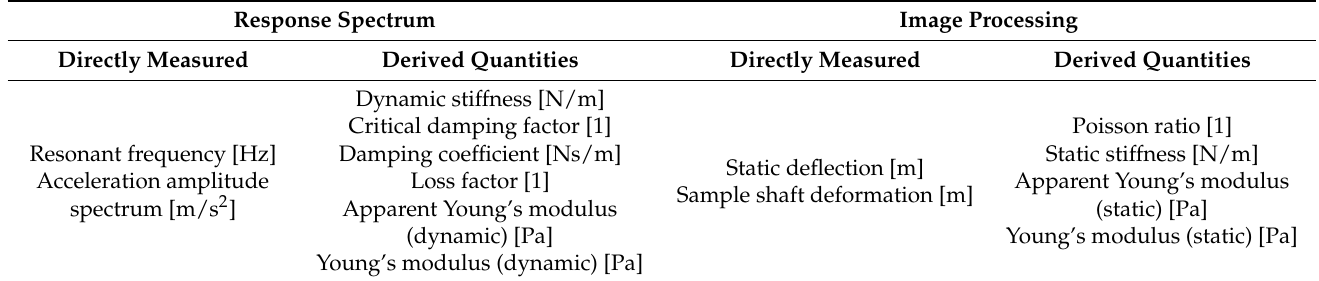
Figure 1. Scheme of research carried out in the article. Table 1. Measured parameters as part of methods using response spectrum and image processing.